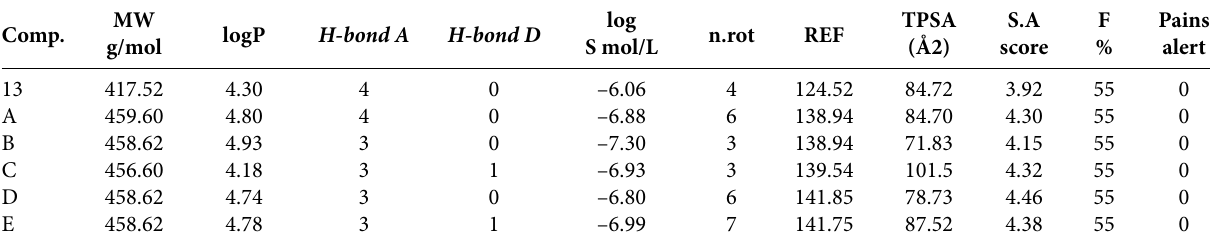
Table 5. Prediction of molecular properties descriptors of the new compounds design